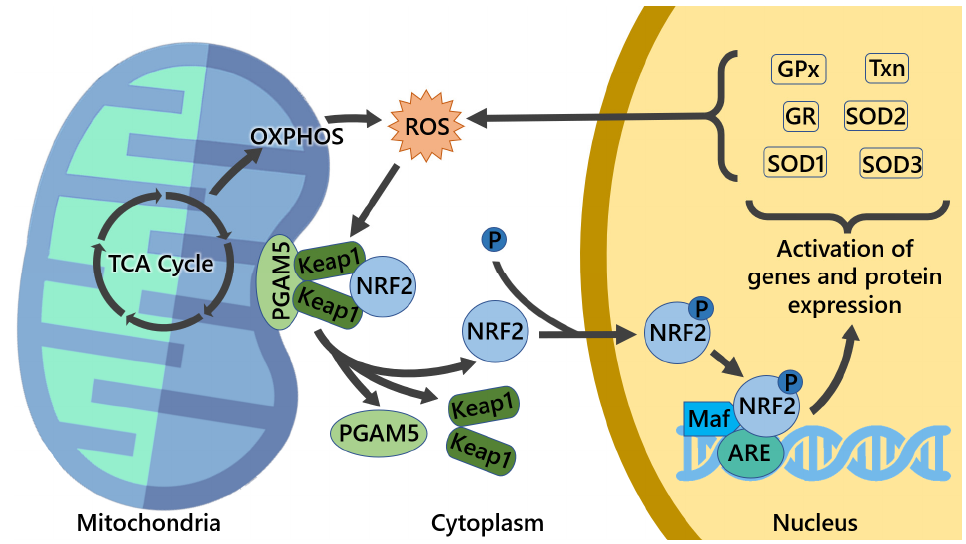
Figure 5. Modulation of NRF2 by mitochondrial ROS leads to the activation of ARE-associated genes and the expression of antioxidant proteins such as GPx (glutathione peroxidase), GR (glutathione reductase), TXn (thioredoxin), SOD1, SOD2, and SOD3 (superoxide dismutase 1, 2, and 3, respectively). When redox imbalance occurs, free radicals are generated, inducing NRF2 release from KEAP1, which, upon proteasomal degradation, translocates to the nucleus and binds to ARE to start the transcription of antioxidant enzymes to, in turn, counteract the oxidative stress from mitochondria and/or the whole cell. PGAM5 is a mitochondrial protein with an important role in mitochondrial dynamics and homeostasis that interacts with both NRF2 and KEAP1, composing a ternary complex, NRF2–KEAP1–PGAM5, reinforcing the crucial role in the health maintenance of mitochondrial function and homeostasis.